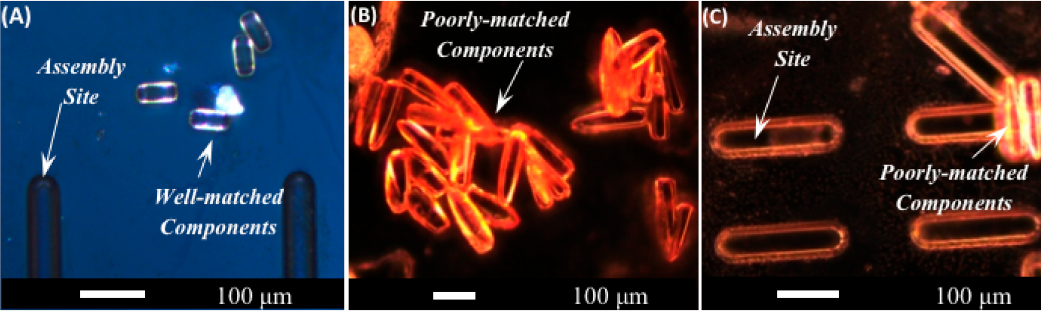
Figure 5. Optical micrographs of portions of the assembly template before assembly, showing two sets of anisotropic assembly components lying on (but not assembled into) the assembly template. ( A ) shows the shorter components that are well-matched to the template geometry, with 26 μ m diameter and 50 μ m length. ( B , C ) show the longer components that are poorly-matched to the template geometry. The poorly-matched components have a length of 150 μ m and taper from a maximum diameter of 26 μ m to a visibly narrower point at the opposite end.